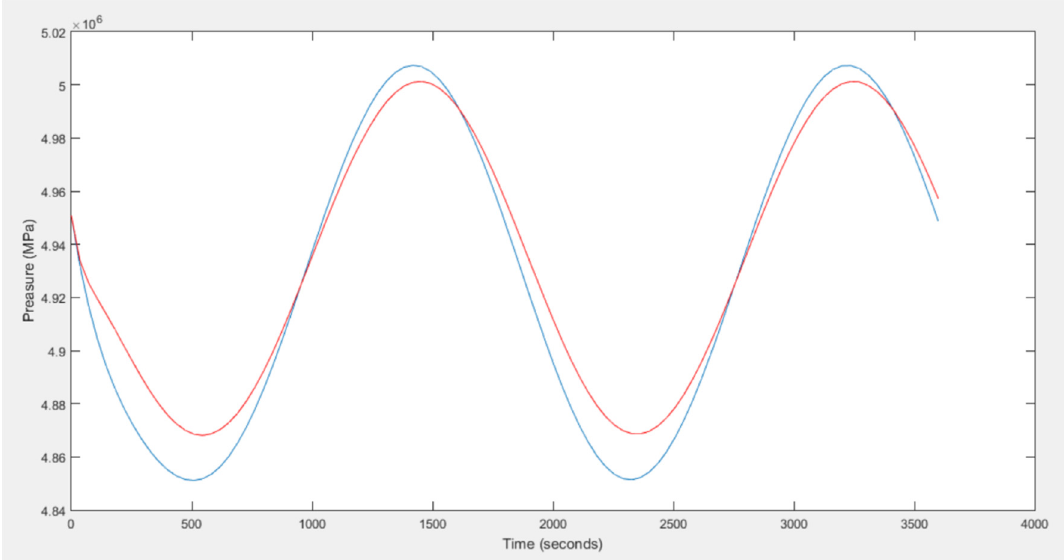
Figure 9. Length = 50 km, diameter = 0.7 m, mass flow = 60 kg/s .